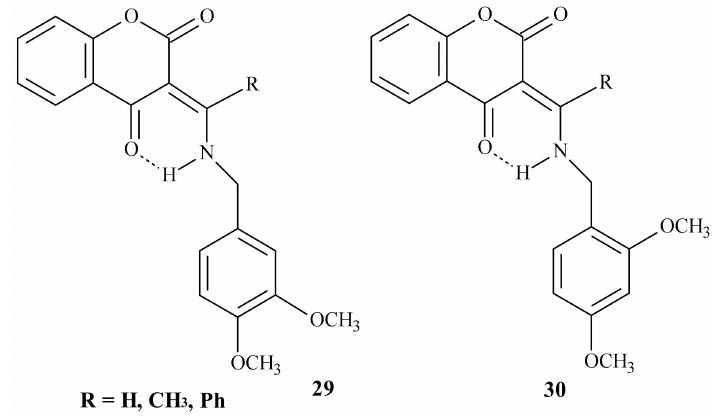
Figure 12. Coumarin derivatives 29 – 30 with two OMe groups in the benzylamine moiety. The compounds 28 – 30 (in Scheme 9 and Figure 12) were docked to the vitamin K epoxide reductase complex (subunit 1) and human serum albumin (HSA) to assess their possible anticoagulant e ff ect in comparison to the warfarin enantiomers